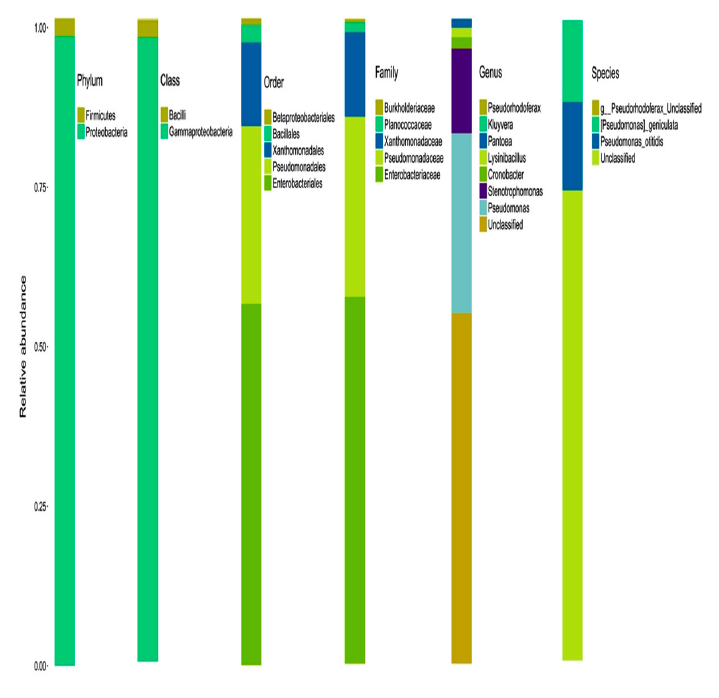
Fig 1. Graphic representation of relative abundance of different